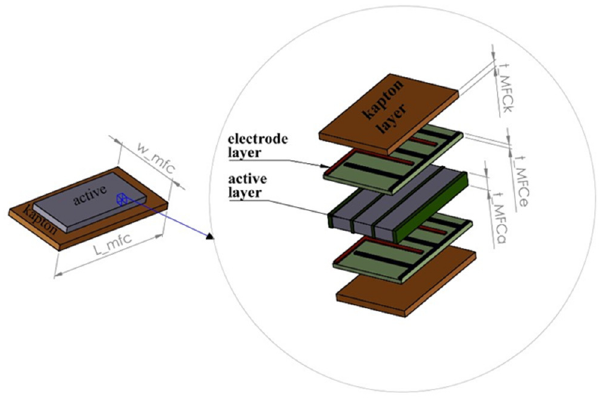
Figure 2. The structure of the macro-fiber composite.